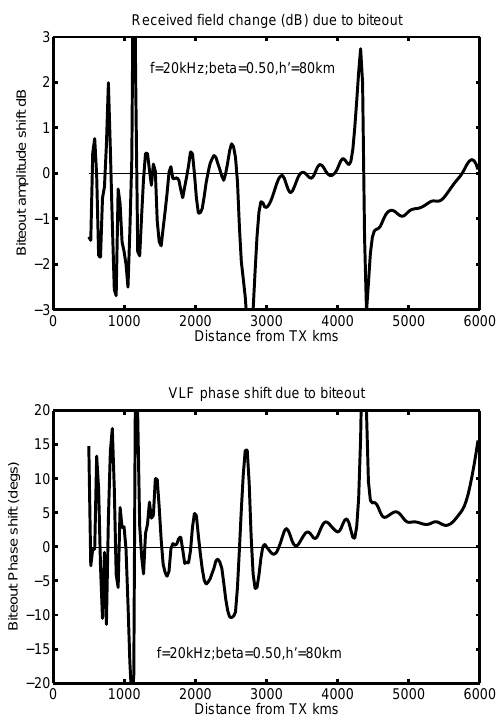
Fig. 4. Change in received amplitude and phase of subionospheric VLF propagation, due to biteout. The graph is for f =20kHz and is plotted as a function of range. The perturbation is generally negative (typically ∼− 1dB) and positive phase (typically ∼ 4 ◦ ) with spikes at modal interference minima. Propagation at short range is strongly multimodal, and received amplitude is rather